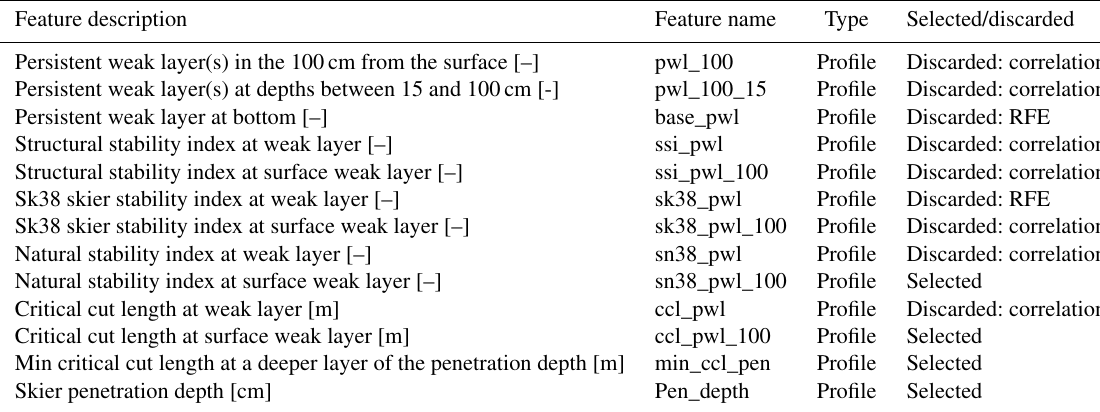
Table C2. Variables extracted from the simulated profiles used for training the random forest algorithm. Features can be discarded by recursive feature elimination (RFE) or because they are highly correlated with another